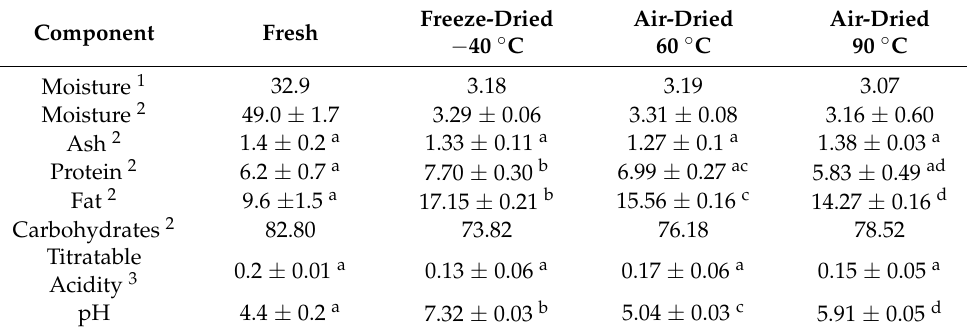
Table 2. Chemical composition of wild blueberry ( Sideroxylon mascatense ) seeds.